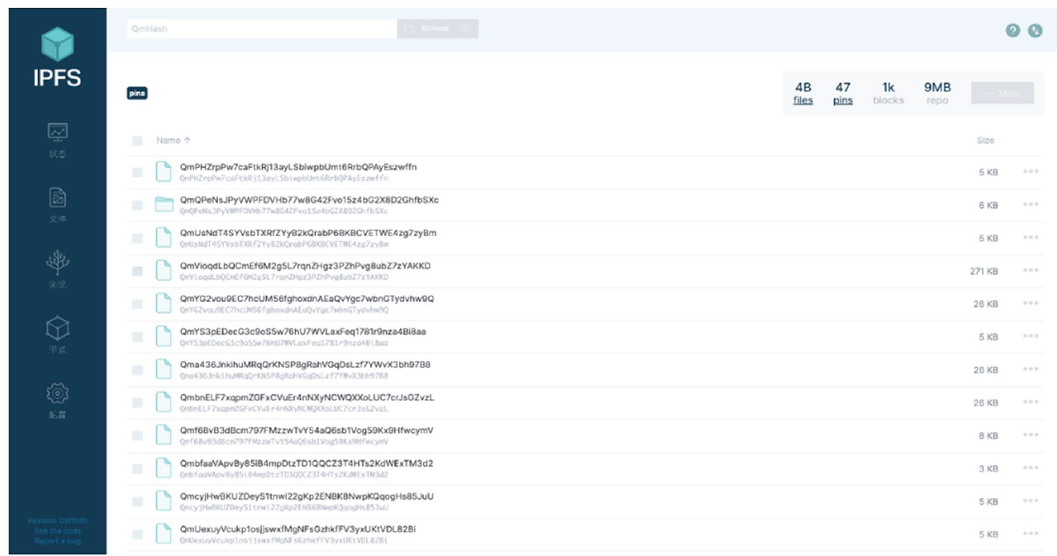
Figure 5. Test results on